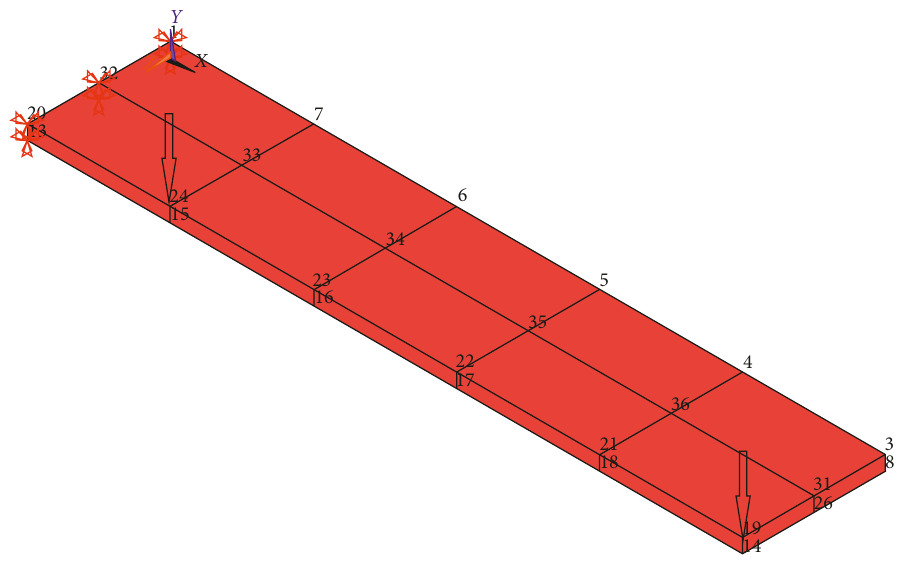
Figure 12: Finite element model of a 3D cantilevered beam.